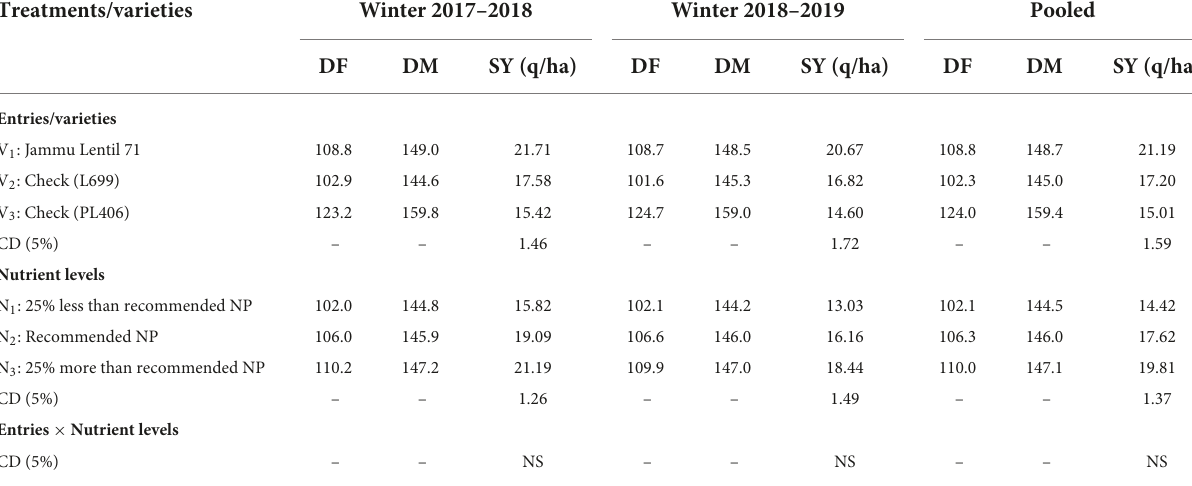
TABLE 9 Performance of selected derivative Jammu Lentil 71 at different levels of nutrients under rainfed conditions of Jammu region.